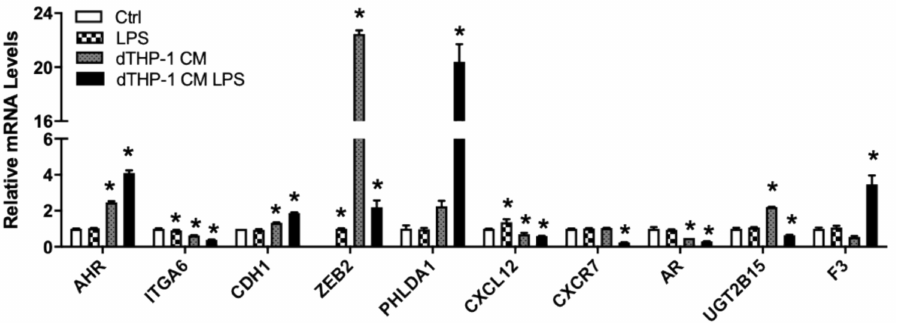
Figure 7. Relative mRNA levels of selected genes in LNCaP cells treated with THP-1 macrophage conditioned media. LNCaP cells were cultured in RPMI-1640 media with or without LPS, and THP-1 macrophage-conditioned media with or without LPS, as described in Materials and Methods. RNA isolation and gene expression were determined using real-time RT-PCR, as described in Materials and Methods. Results were normalized to the untreated control and expressed as relative mRNA levels (mean ± SD, n = 3); p -values ≤ 0.05 were considered as significant and * indicates significantly different from